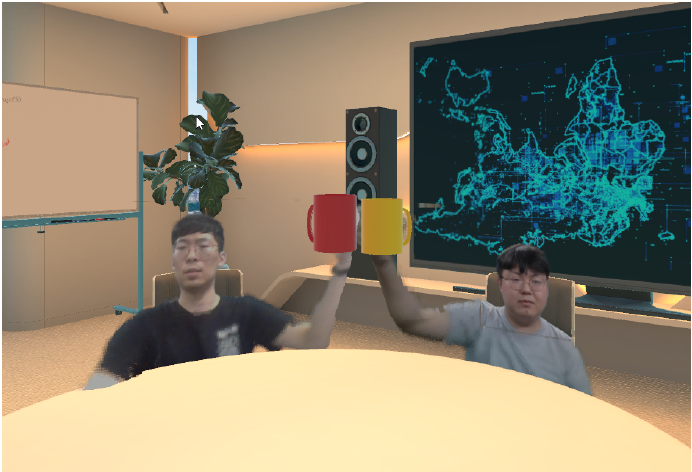
Figure 13. Multi-person use pixel avatars to interact with virtual objects in virtual